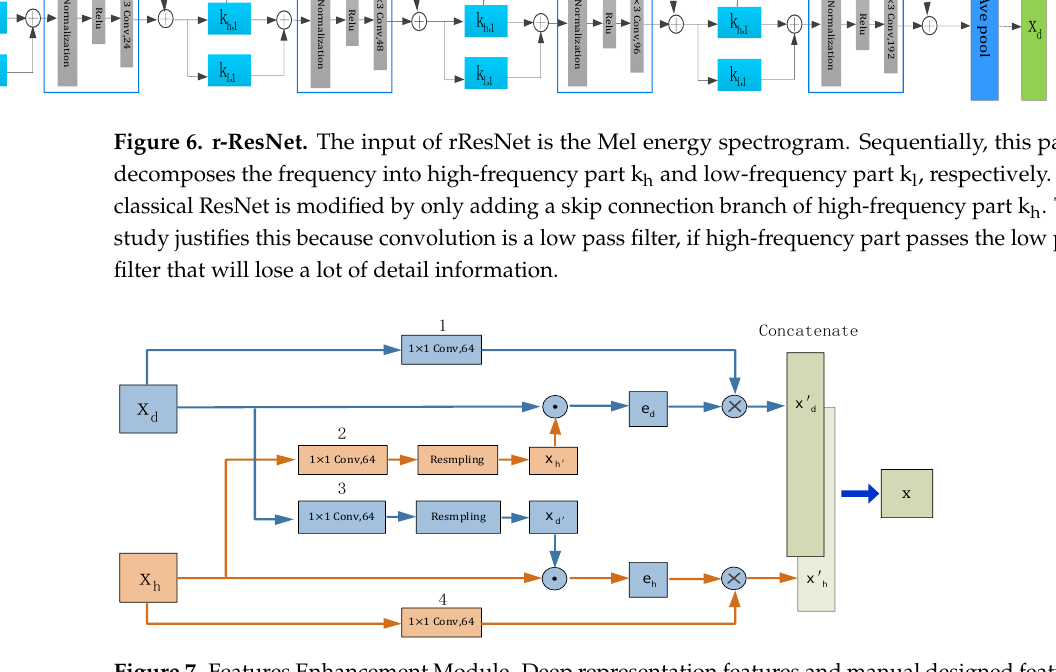
Figure 7. Features Enhancement Module. Deep representation features and manual designed features are enhanced by scaled dot-product attention. The 1 × 1 convolutions at positions 2 and 3 are used to extract the feature parameters of X d and X h , and the convolutions at positions 1 and 4 are used to match the number of feature channels extracted. Resampling operation applies the interpolation method to adjust the features’ dimensions in order to operate dot-product.